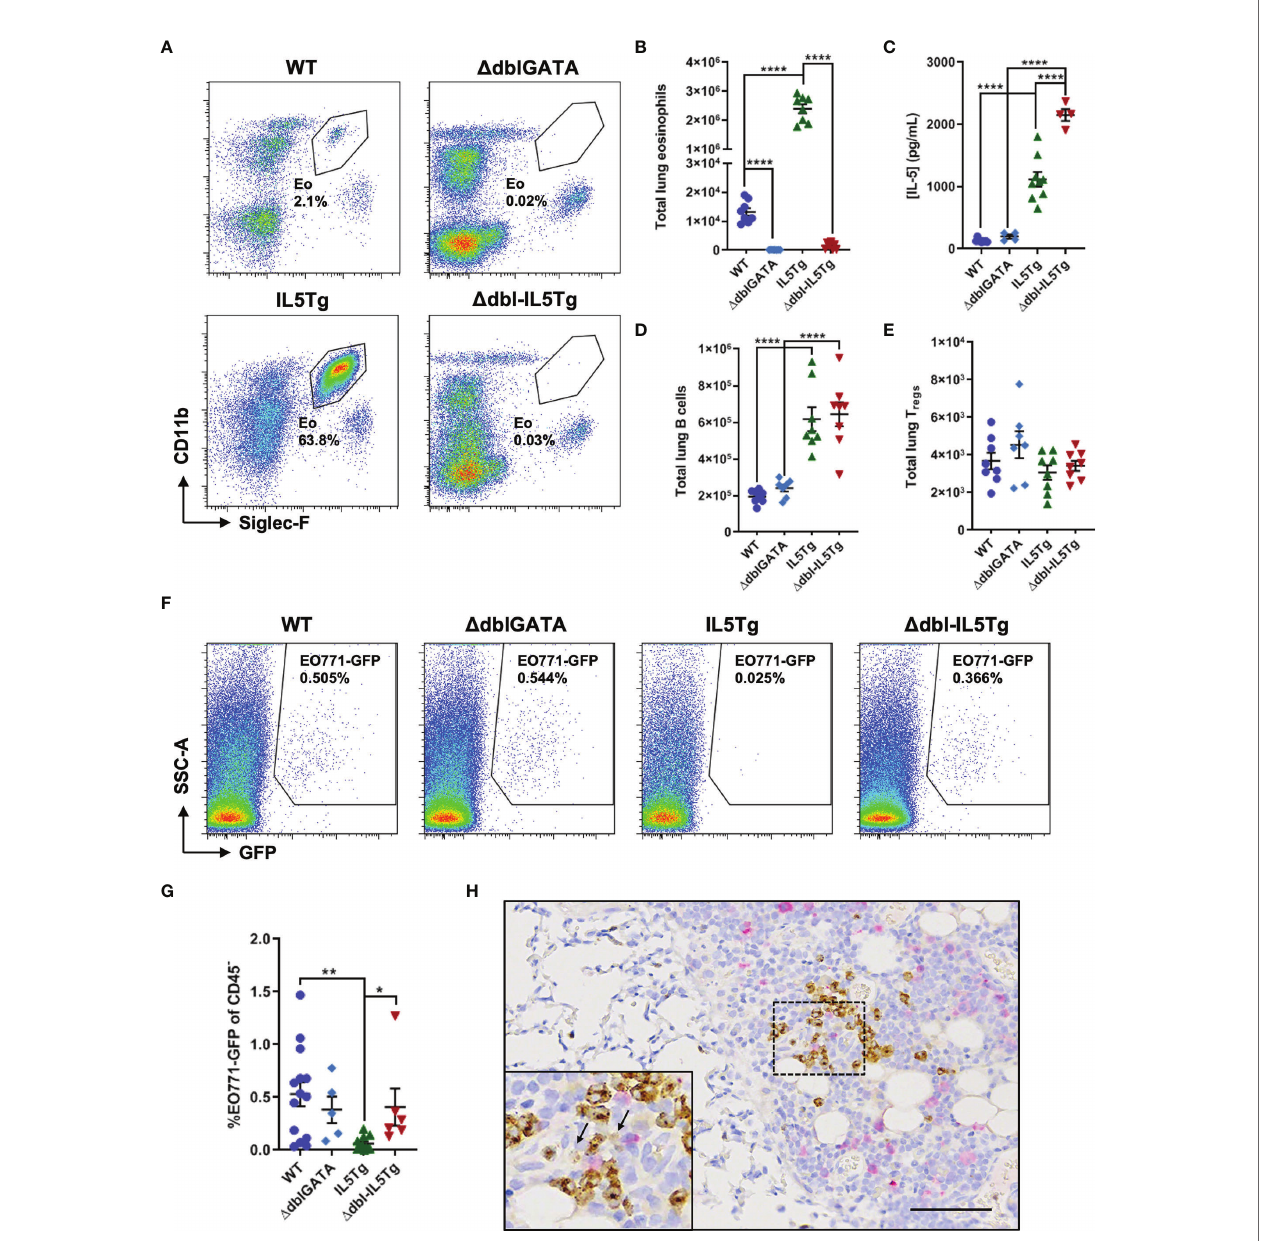
FIGURE 3 | Eosinophils inhibit early pulmonary colonization of EO771 tumor cells in IL5Tg mice. (A) Representative fl ow plots of lungs collected from naïve WT, D dblGATA, IL5Tg, and D dblGATA-IL5Tg ( D dbl-IL5Tg)mice. (B) Total number of eosinophils in the leftlunglobe of naïveWT, IL5Tg, D dblGATA, and D dbl-IL5Tg mice. (C) Quanti fi cation of circulatingIL-5 inthe serum ofWT, D dblGATA, IL5Tg, and D dbl-IL5Tg mice. (D) Total number of B cells (CD19 + ) and (E) T regs in the leftlunglobeof naïve WT, IL5Tg, D dblGATA, and D dbl-IL5Tg mice. (F) Representative fl ow plots of WT, D dblGATA, IL5Tg, and D dbl-IL5Tg mouse lungs 5 dayspost-i.v.injection of EO771-GFP cells. Samples pre-gated on CD45 - cells. (G) Frequency (as a proportion of CD45 - cells) of EO771-GFP cells in the lungs ofWT, D dblGATA, IL5Tg, and D dbl-IL5Tg mice5 days post-i.v. injection of EO771-GFPcells. (H) Representative lungIHC of an IL5Tg mouse 6 hours post-i.v.injection of EO771-GFP cells. Sections were co-stained with anti- mMBP to identify eosinophils (brown)and anti-GFPto visualize EO771 tumorcells (pink). Black arrows in insetindicate diffuse MBP staining indicative of degranulating eosinophils. Scale bar = 100 m m. Data points are individual mice with mean ± SEM of 5-14 mice per group. *p < 0.05; **p < 0.01; ****p <